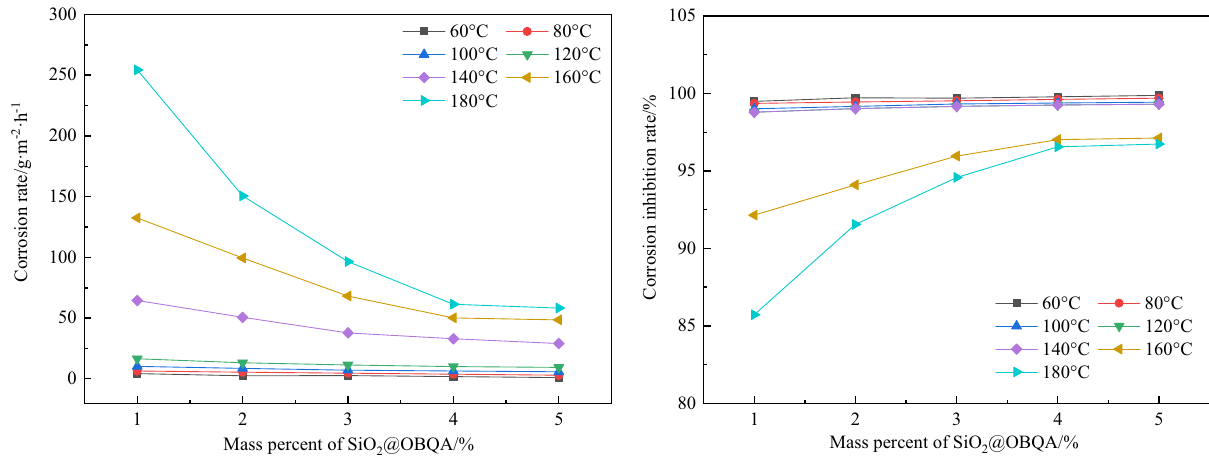
Figure 8: The in fl uence of nano - SiO 2 @OBQA concentration on corrosion inhibition performance at di ff erent temperatures.